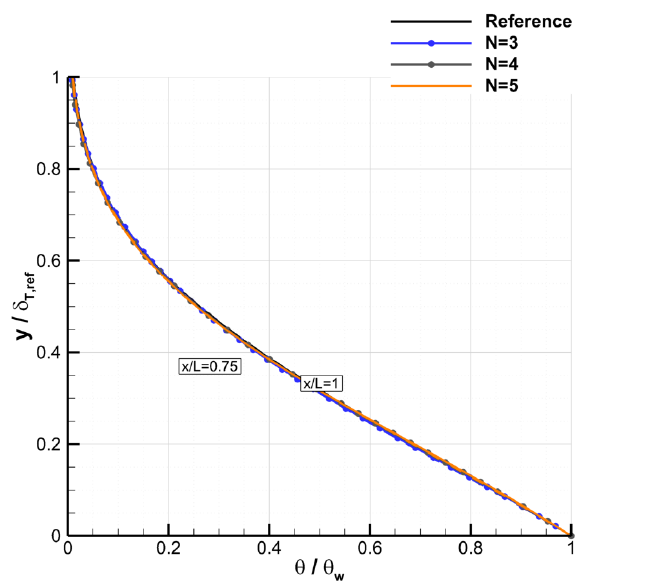
Figure 14. Temperature profiles for several x / L locations, and for the reference CLICET solution. Test case 3, m = 1. N x =